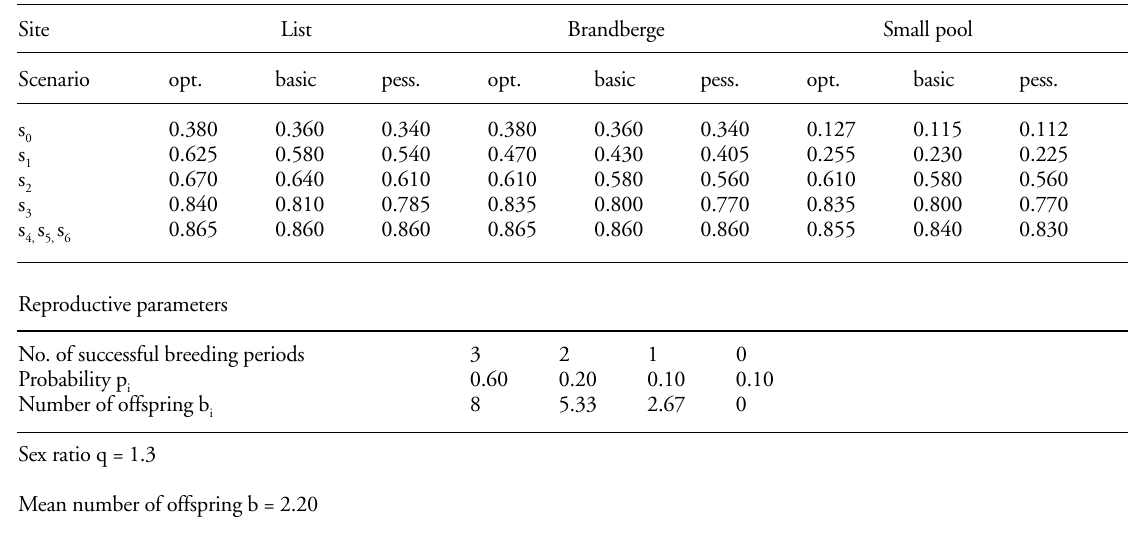
Table 4. Parameter overview for the Leslie matrix model. Mean rates are calculated as weighted averages over the environmental conditions (see text). Mean survival rates for different scenarios and sites Site List Brandberge Small pool Scenario opt. basic pess. opt. basic pess.